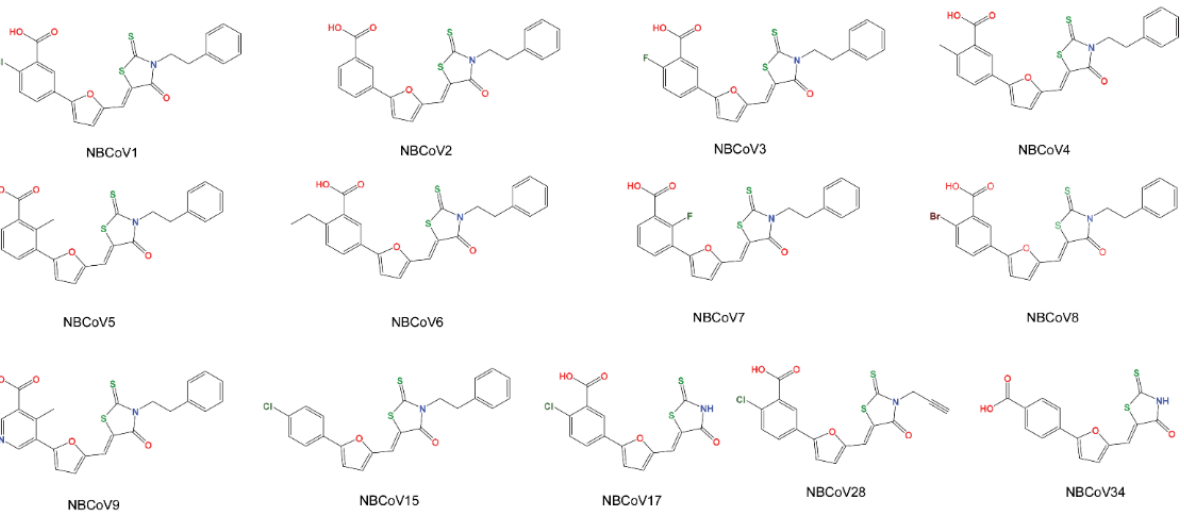
Figure Figure 1 . The structures of all of compounds derived from 5-((5-4-cholorophenyl)furan-2-yl)meth- ylene)-3-phenethyl-2-thioxothiazolidin-4-one that were tested against SARS-CoV-2, SARS-CoV, and MERS-CoV.